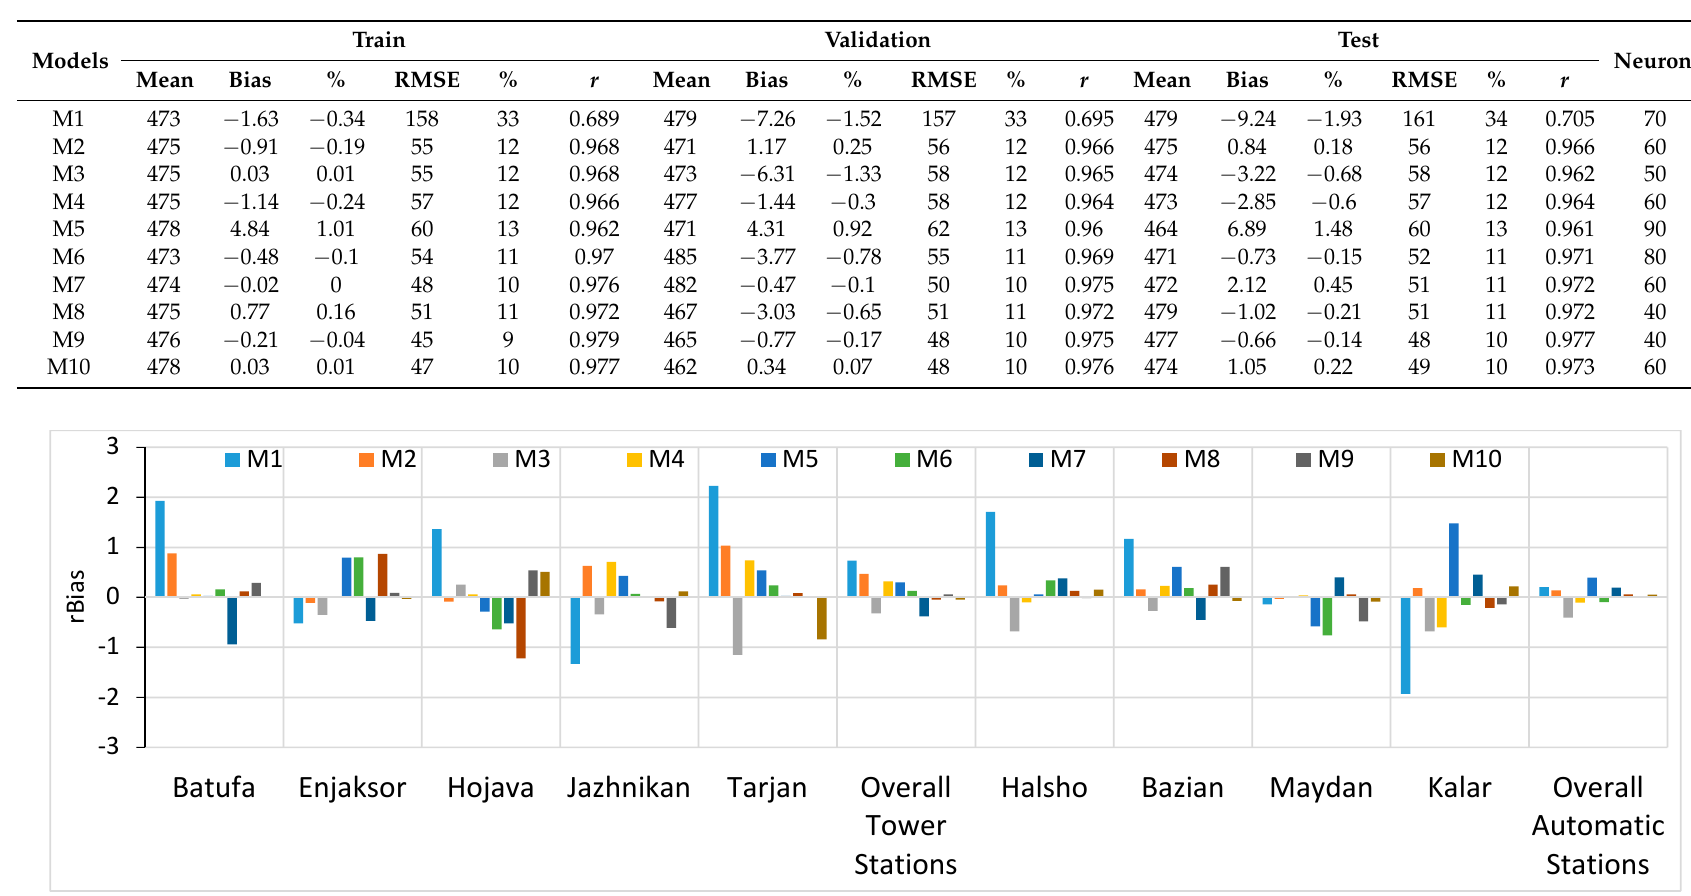
Table A9. As in Table A1, but for Kalar automatic station.